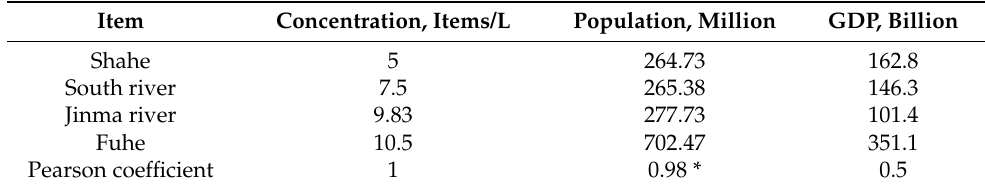
Table 2. The correlation coefficients of population and GDP with concentration (GDP: gross domestic product. GDP is an important indicator to measure the economic status and development level of a country or region.). Item Concentration, Items/L Population, Million GDP,